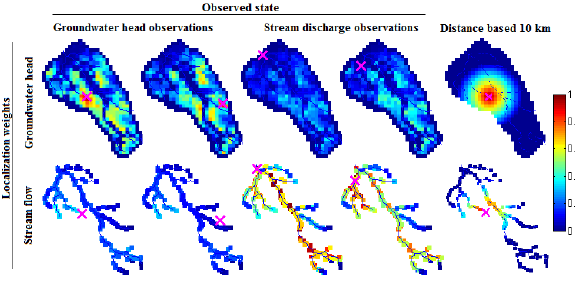
Figure 5. Mean localization weight derived from the adaptive local- ization algorithm for different observation locations and observation types. Two groundwater observations and two stream discharge ob- servations are included – magenta crosses indicate the observation locations. The two left columns show localization weights for the two groundwater head observations, the third and fourth columns show localization weights for the two discharge observations. An example of the localization weights as obtained using the distance- based localization method, with a localization distance of 10km, is included for comparison on the right.